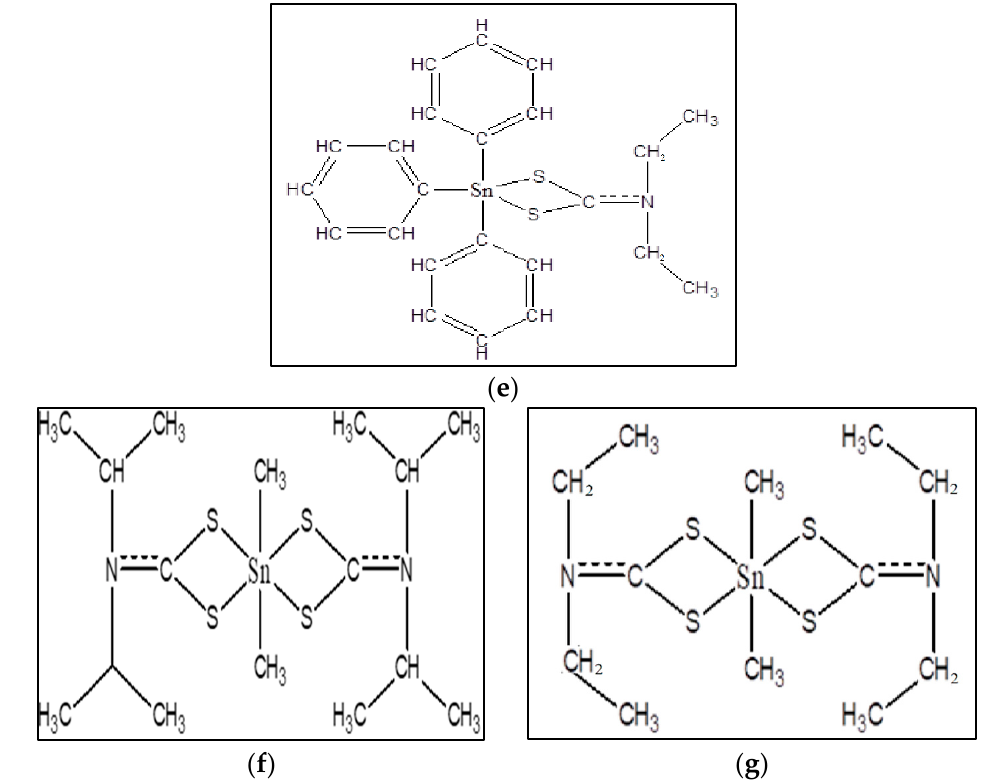
Figure 1. Chemical structure of ( a ) ODTC 1, ( b ) ODTC 2, ( c ) ODTC 3, ( d ) ODTC 4, ( e ) ODTC 5, ( f ) ODTC 6, and ( g ) ODTC 7 [21,22].